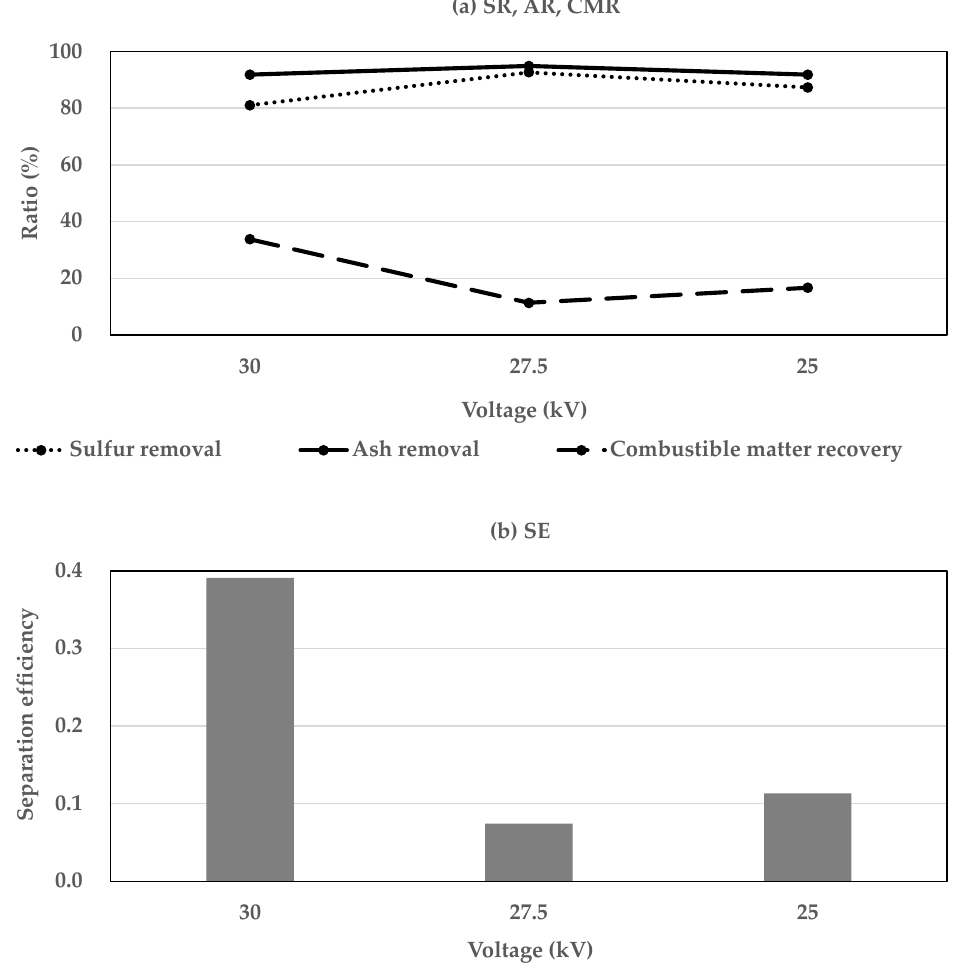
Figure 3. Ash ratio (%), coal ratio (%), and sulfur ratio (%) of particles collected from tray numbers 1–12 at different electrode voltages: ( a ) 30 kV; ( b ) 27.5 kV; ( c ) 25 kV using a dry coal cleaning system with two-stage corona electrostatic processes.